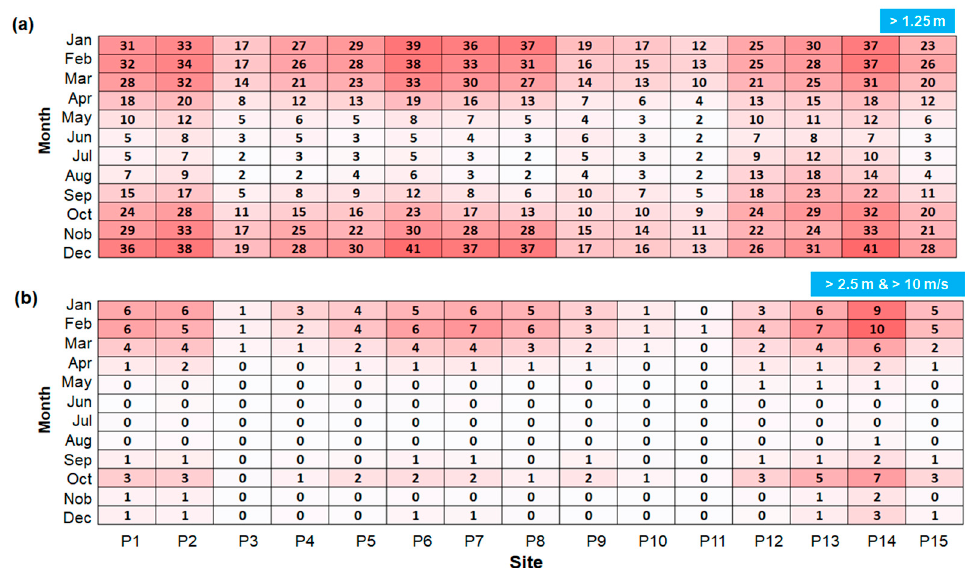
Figure 9. Monthly distribution of the adverse weather conditions (in %) reported for: ( a ) Hs > 1.25 m; ( b ) Hs > 2.5 m and U 10 > 10 m/s.